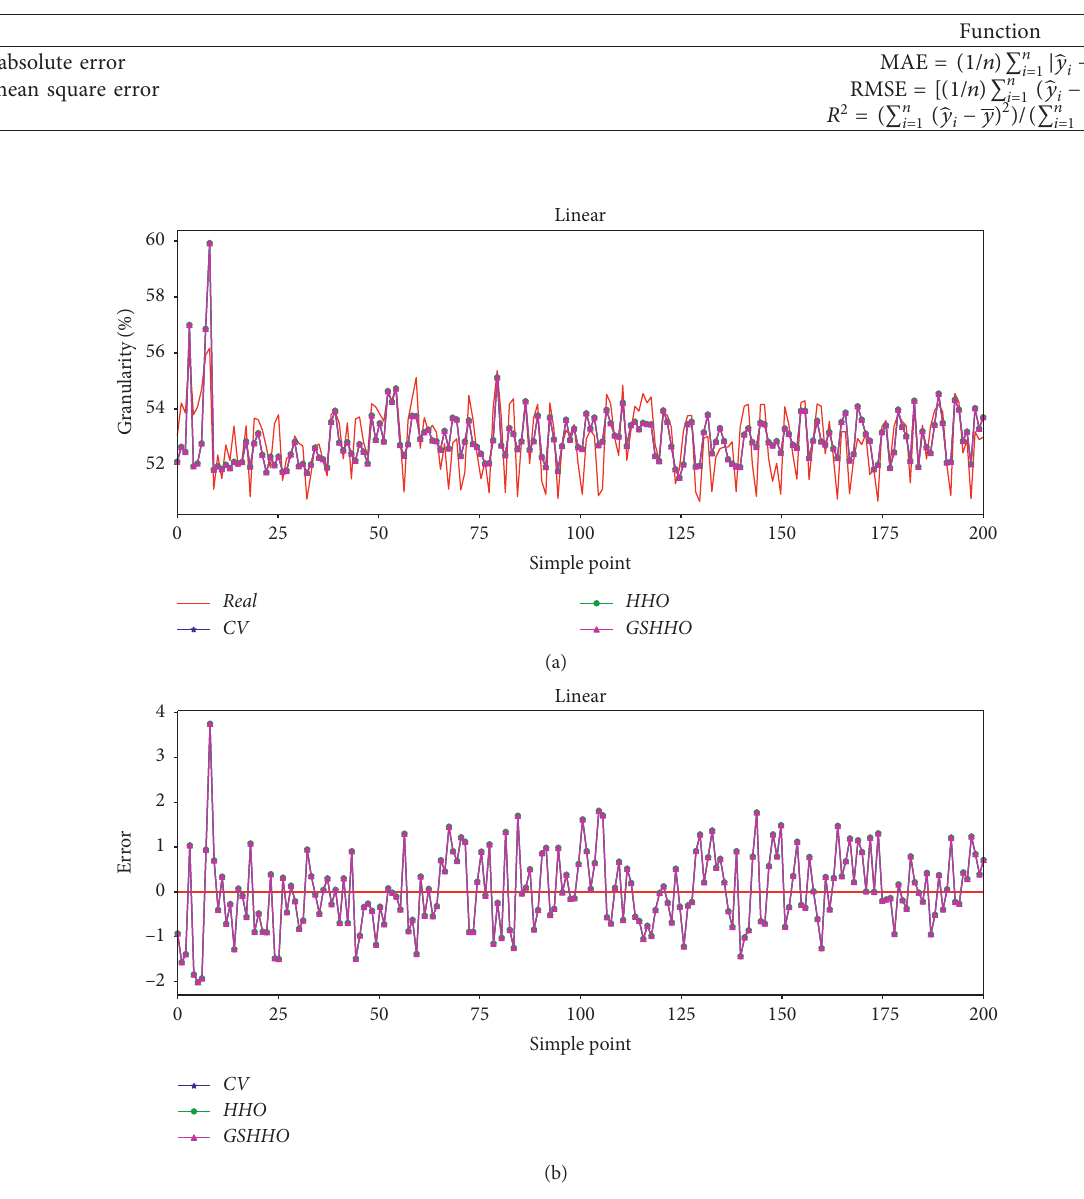
Figure 7: Prediction results under LSSVM model with linear function. (a) Prediction results under different LSSVM models. (b) Prediction errors under different LSSVM models.